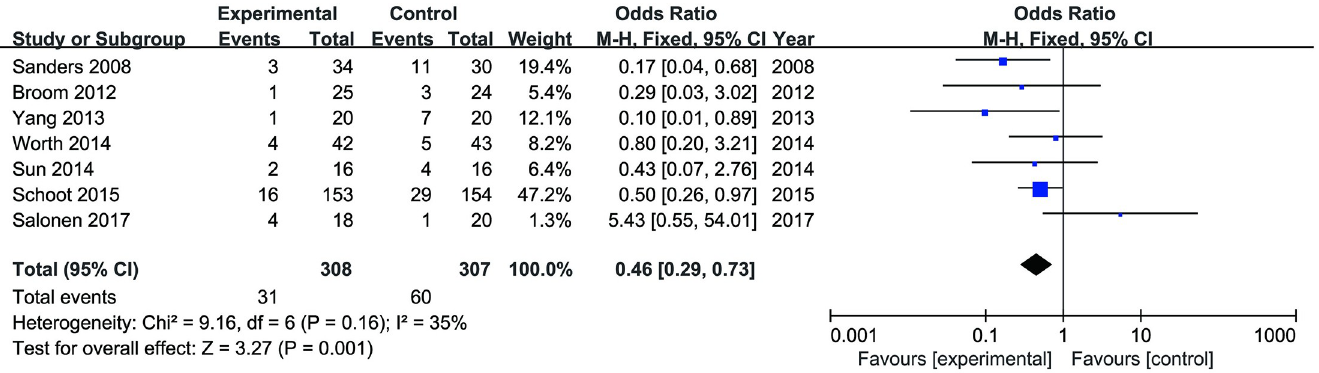
PLOS ONE | https://doi.org/10.1371/journal.pone.0222408 September 12,